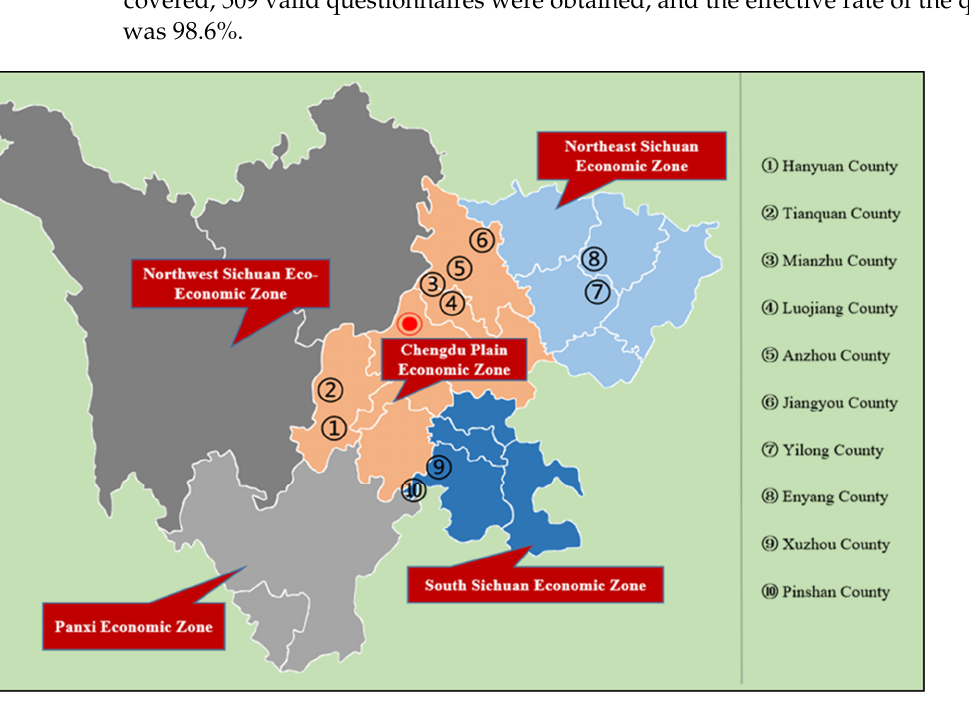
Table 2. Comparison of the mean difference between the input of production factors of demonstra- tion cooperatives and non-demonstration cooperatives. Total Sample Demonstration Cooperatives Non-Demonstration Cooperatives Mean Diff.